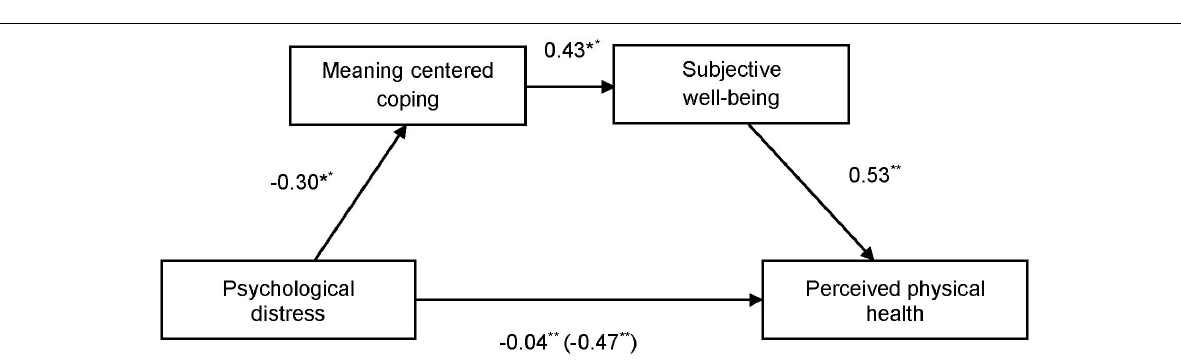
FIGURE 2 | Mediational analysis of meaning cantered coping in the relation between psychological distress and perceived physical health. Direct effects after including the mediator are in brackets. ** p ≤ 0.001; * p ≤ 0.05.